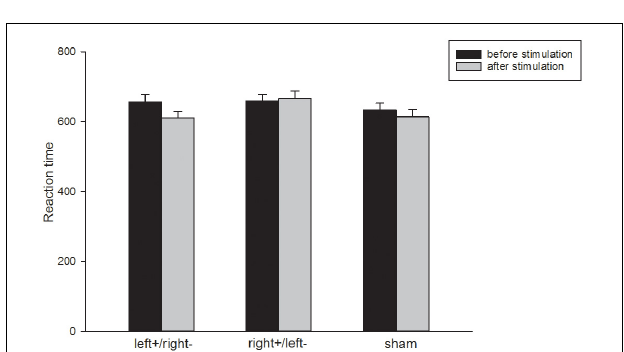
FIGURE 4 | Accuracy in the 2-back task. Black bars, pre-transcranial direct stimulation (pre-tDCS); gray bars, post-tDCS. The subjects’ accuracy in the 2-back task showed a significant increase in the left+/right– group and no significant differences in the right+/left– or sham groups. ∗∗∗ p < 0.001, Error bars indicated 95% confidence intervals.